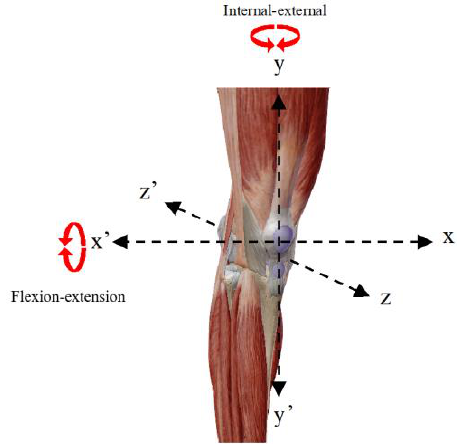
Figure 1. Degrees of freedom of the knee joint.